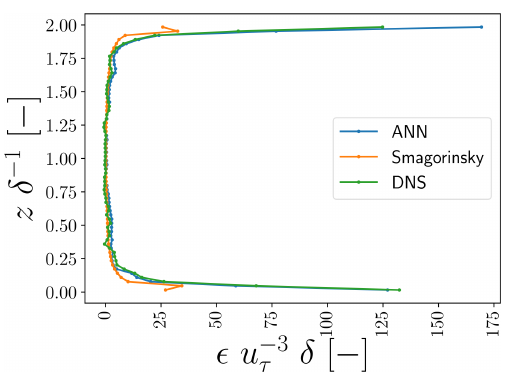
Figure 10. Vertical profiles of horizontally averaged τ wu, DNS , τ wu, ANN , and τ wu, smag at one representative time step not used to train and validate the ANNs. All values are normalized by the friction velocity u − 2 τ and half-channel width δ − 1 .